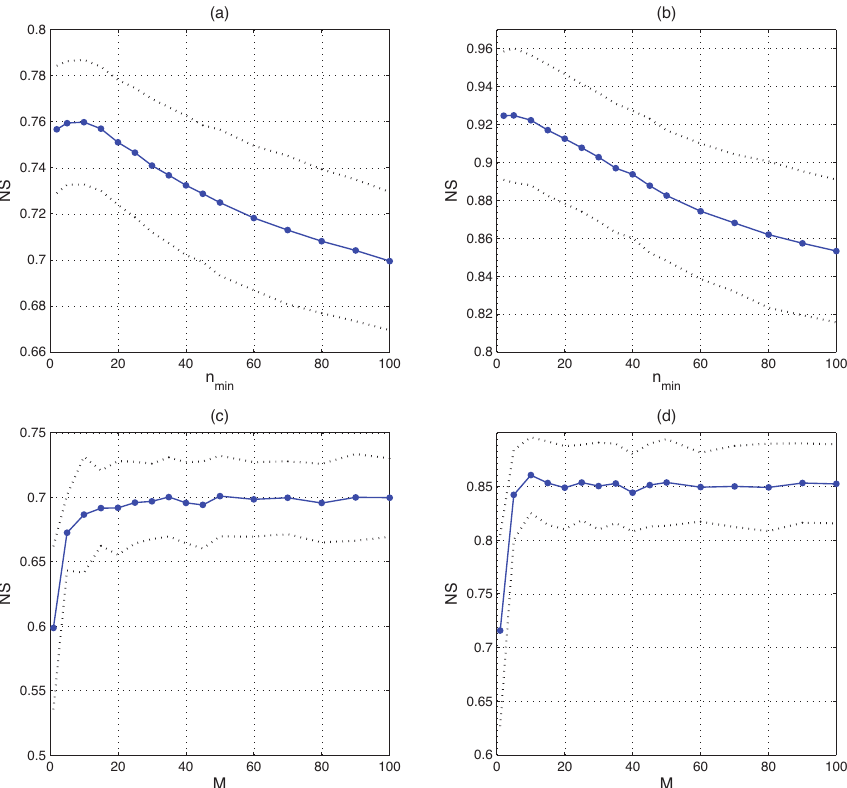
Fig. 4. Values of NS as a function of n min (with M =500) and of M (with n min =100) over the testing subsets for Marina ( a and c ) and Canning River ( b and d ). Dotted lines represent the standard deviation calculated over the the selected 10 data groups of each dataset.